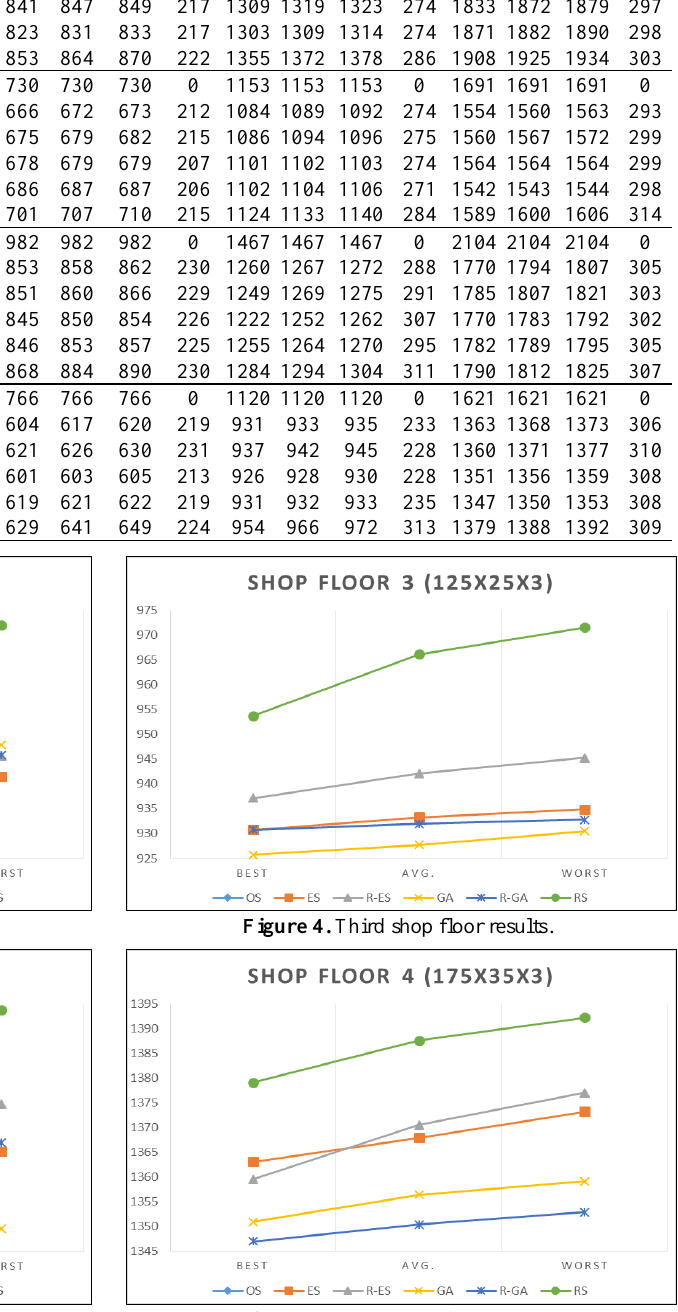
Figure 5. Fourth shop floor